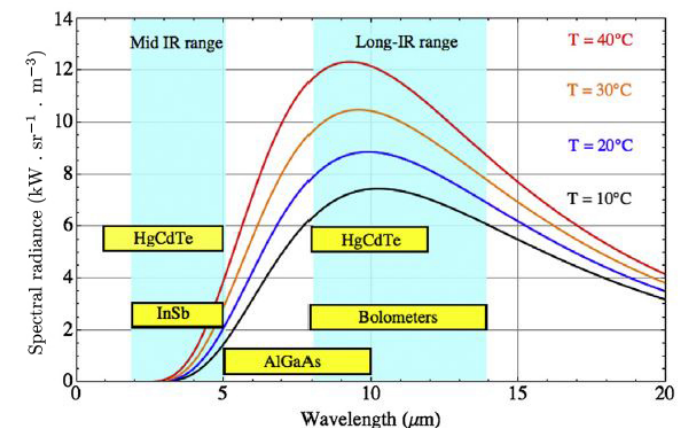
Figure 4. The spectral range of different IR detectors in relation to the spectral radiance of a blackbody at different equilibrium temperatures. Reprinted with permission from Ref. [13]. 2016,